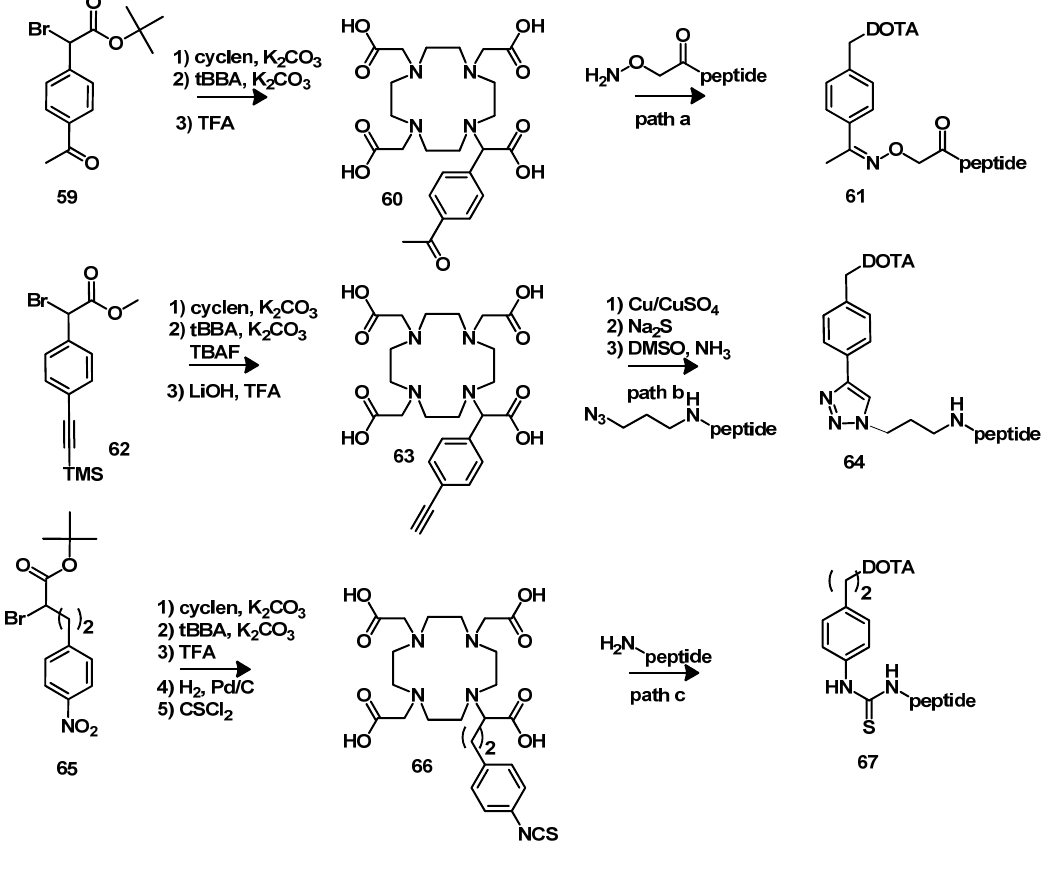
Scheme 7. Synthesis of DOTA bearing